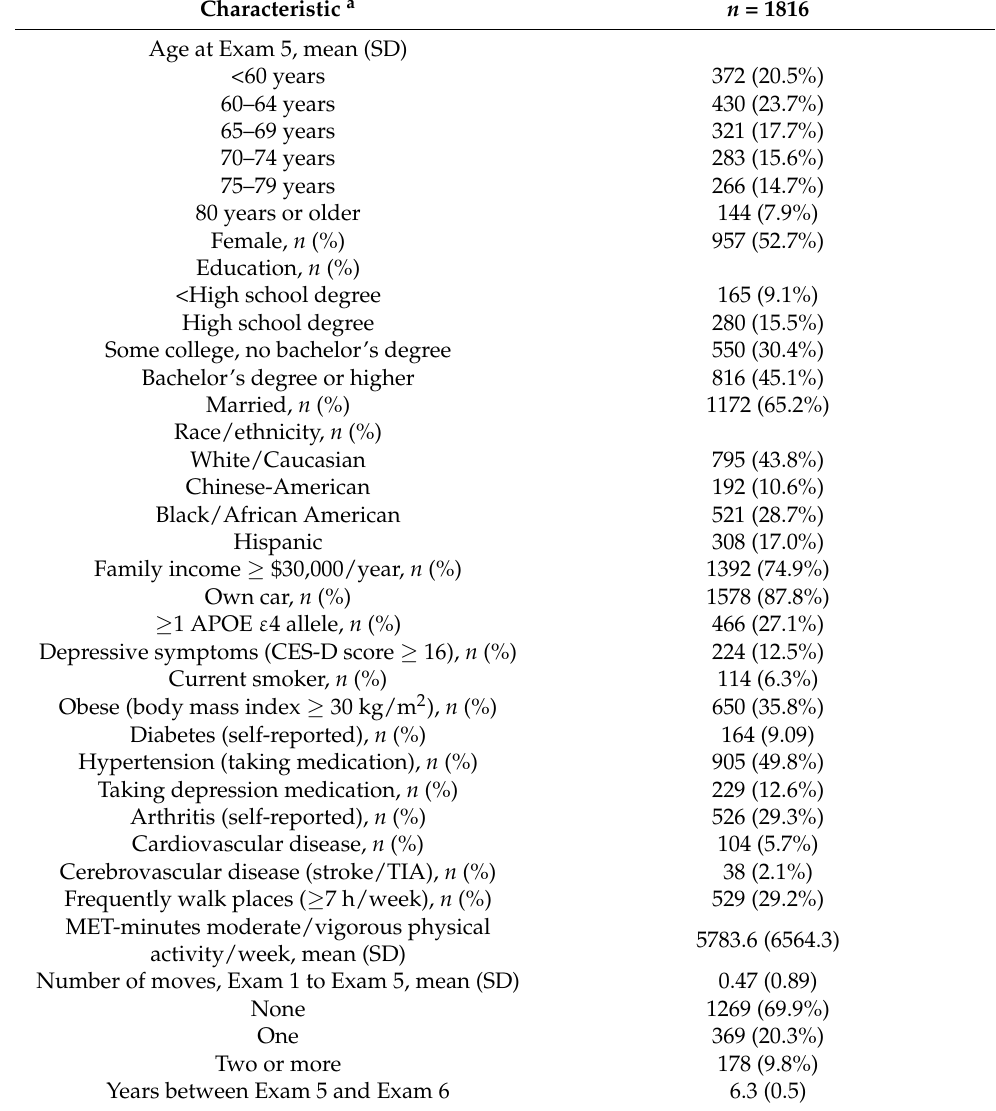
Table 1. Participant